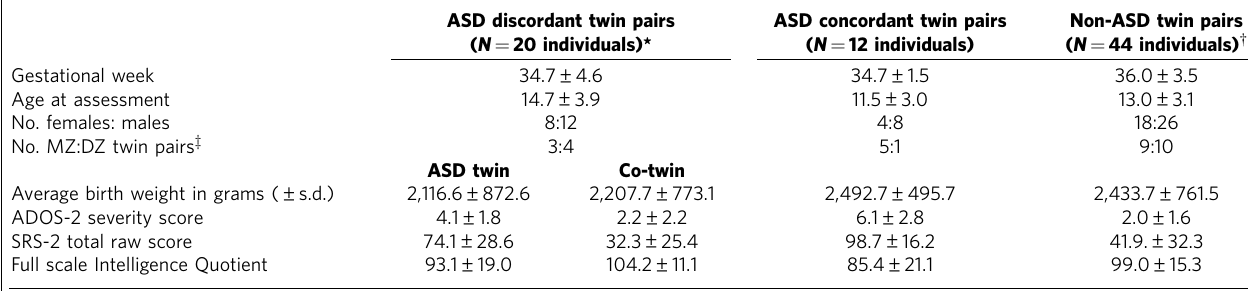
ADOS-2, The Autism Diagnostic Observation Schedule Second Edition; ASD, autism spectrum disorder; DZ, dizygotic; MZ, monozygotic; SRS-2, Social Responsiveness Scale Second Edition. *Six singletons. w Six singletons. z Singletons